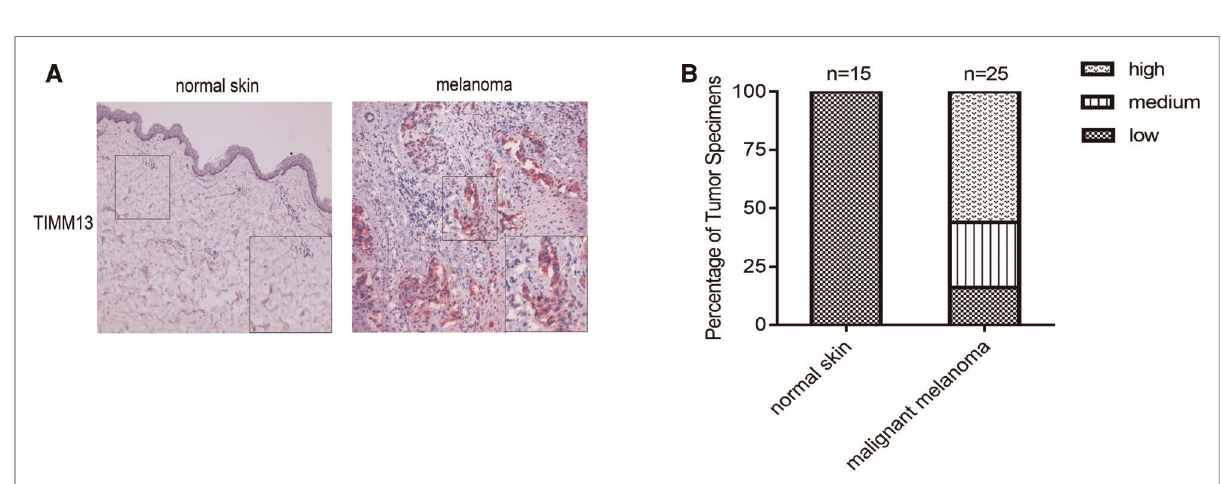
FIGURE 8 Gene expression of TIMM13 in melanoma tissue and normal skin specimens. Using IHC staining, TIMM13 was expressed at higher levels in the melanoma tissue ( n =25) when compared to normal skin ( n =15). ( A ) IHC staining. ( B ) Quanti fi cation of the TIMM13 levels.